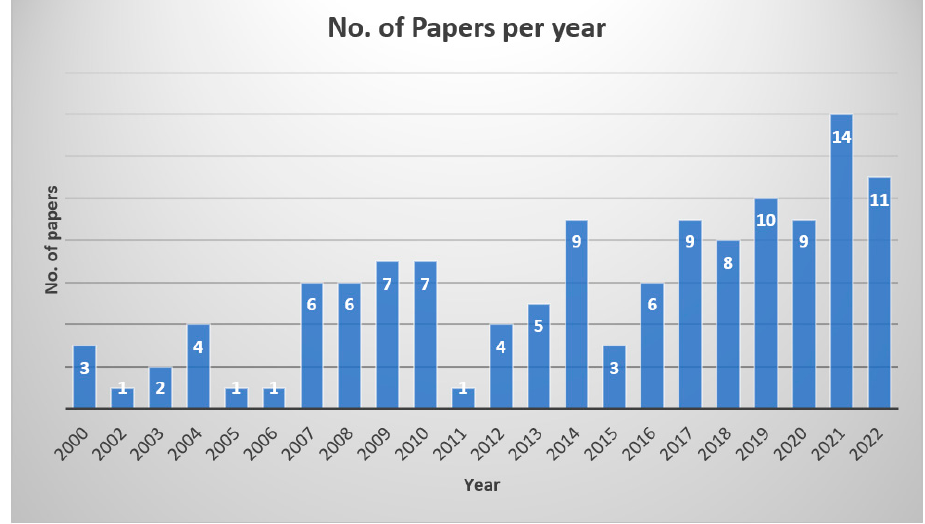
Figure 2. Number of Papers per Year.